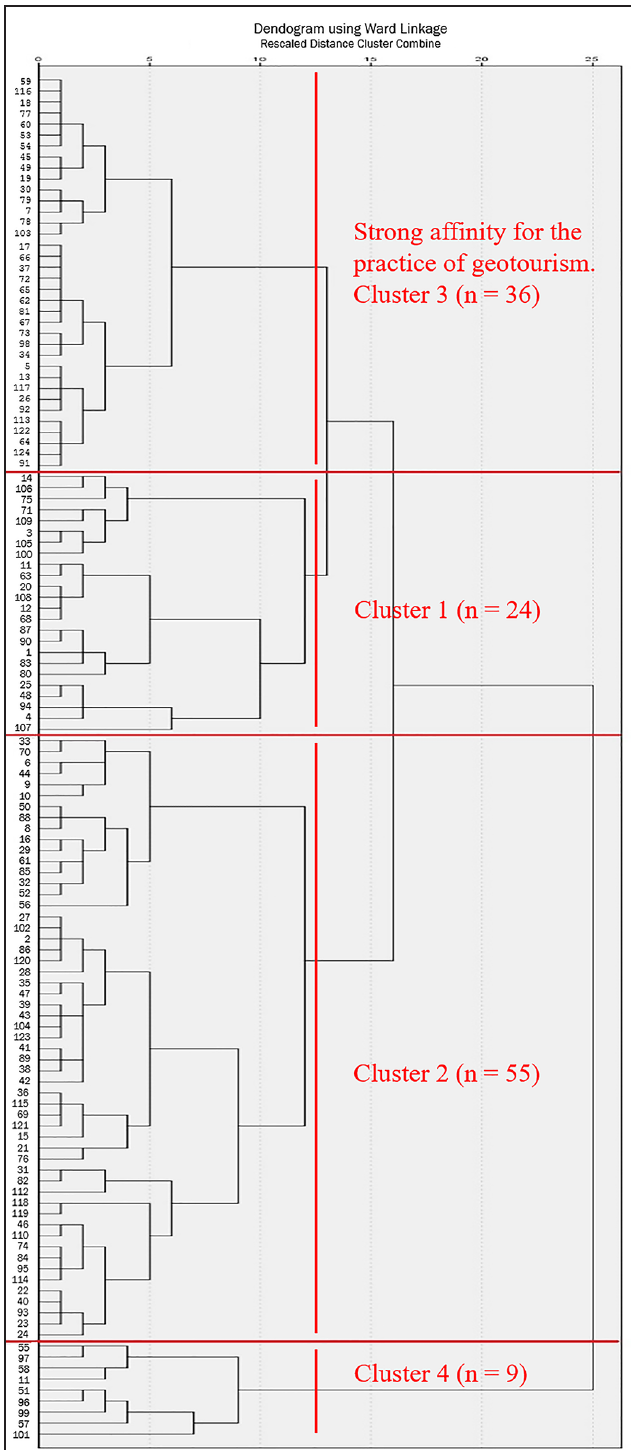
FIGURE 2. Dendrogram with the four tourist groups in the territory of the Serra do Sincorá Geopark Project, Lençóis, Bahia. the reasons “architecture,” “nature,” and “history,” which are related to “general attitudes to leisure travel.” Geotourism (11.4%), caving (8.6%), and rural tourism (8.6%) are the activities that appear less prominently due to the choice of tourists with “strong affinity for the practice of geotourism” (Figure 3). Even though touristic activities focusing on the abiotic portion of nature were not the most mentioned, tourists agree